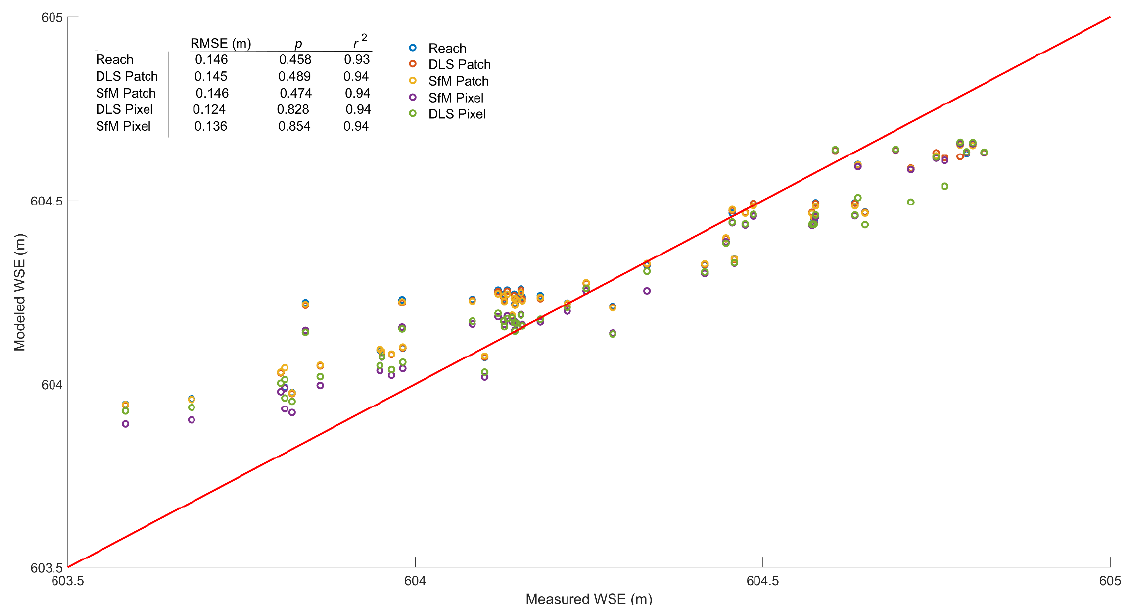
Figure 7. Comparison of measured groundwater well WSE to simulated WSE from the 23 September 2018, 11 October 2018 and 31 October 2019 floods. The RMSEs, p -values and r 2 values are from the validation step. The p -values are outputs of the Wilcoxon Rank-Sum Test.